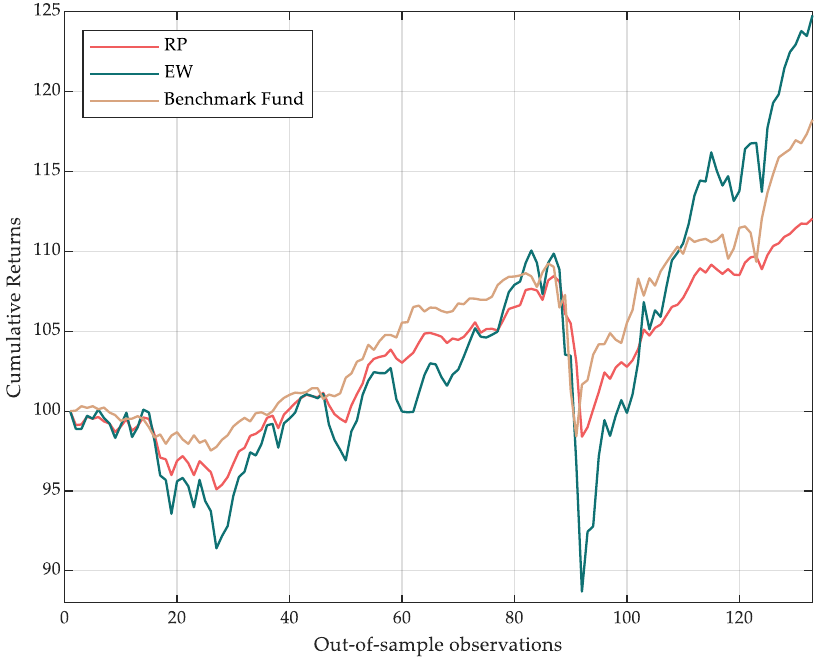
Figure 6. Combined Portfolio returns (in-sample w = 130; out-of-sample w = 132). Note: to improve table clarity, returns were normalised on a scale of 100.